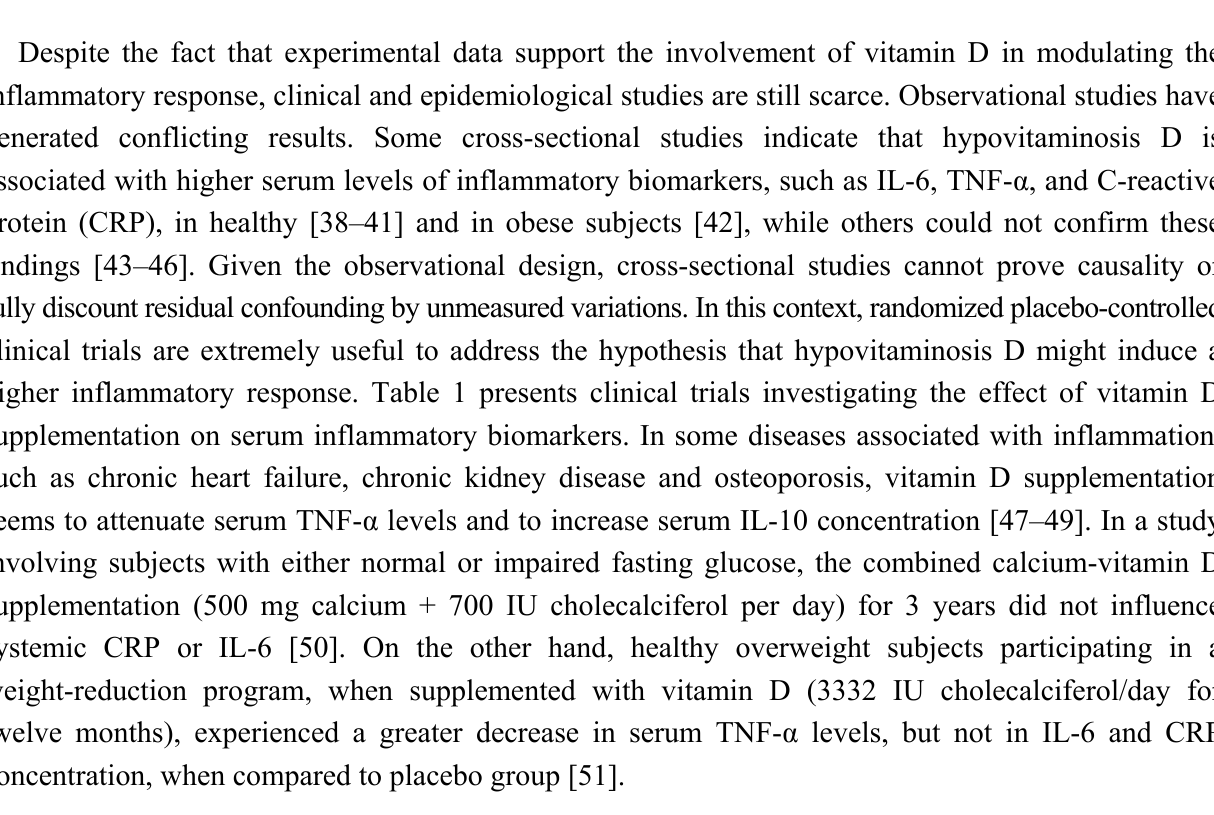
Table 1. Clinical trials investigating the effect of vitamin D supplementation on serum inflammatory